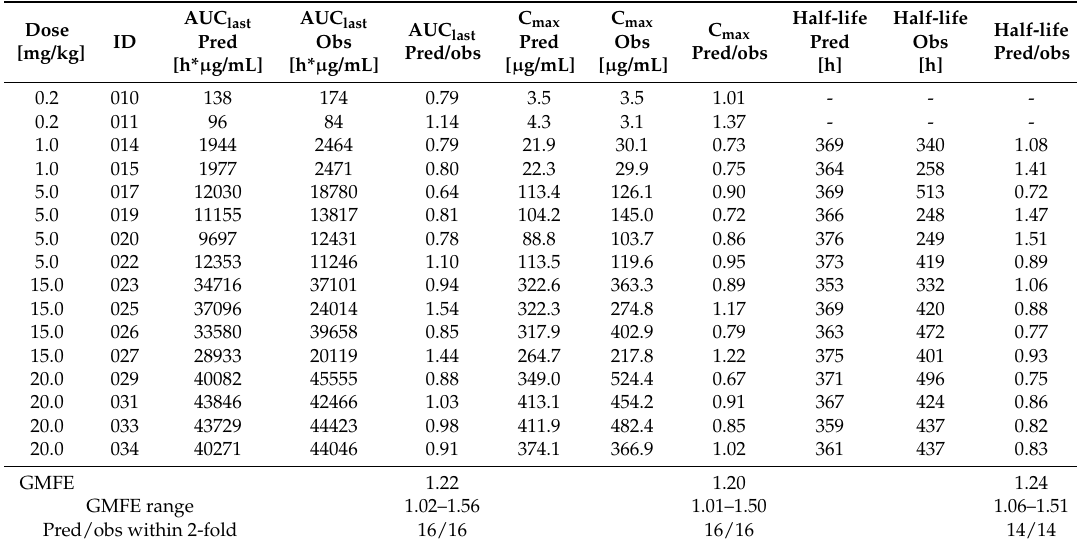
Figure 5. Asunercept predicted versus observed PK parameters illustrating the model performance for the healthy volunteers of study APG101_CD_001 and covering the whole clinically investigated dosing range (0.2, 1.0, 5.0, 15.0, 20.0 mg/kg APG101). Left : AUC last values (start of infusion to the last measured concentration, dark blue, n = 16), middle : C max values (blue, n = 16), right : half-life values (light blue, n = 14). The solid lines represent the line of identity; the dashed lines indicate twofold deviation. The plotted values are listed in Table 3. Table 3. Predicted and observed pharmacokinetic parameters of asunercept.